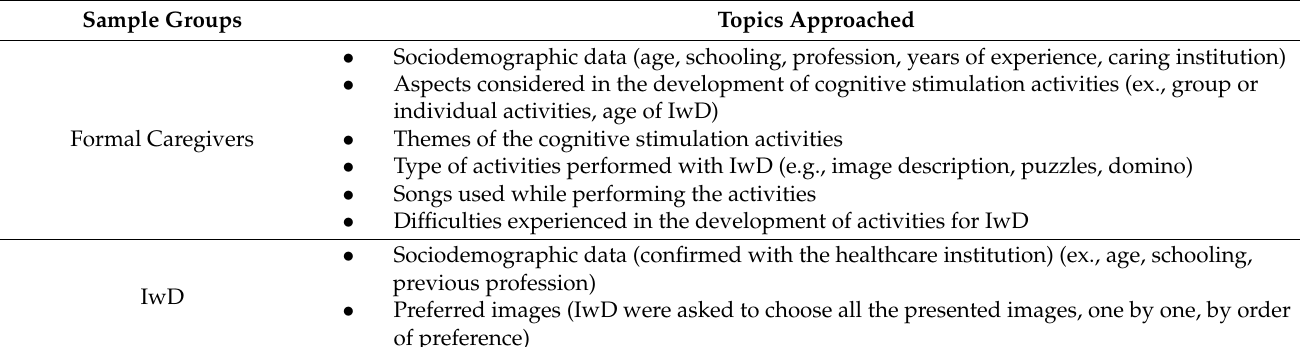
Table 2. Sample groups and topics approached during the information gathering process. Sample Groups Topics Approached